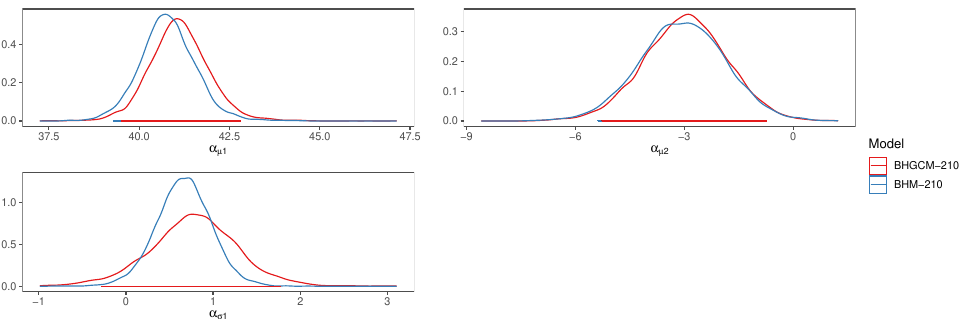
Figure 3. Estimated posterior distribution density functions of the regression coefficients α k 1 ( left ) and α k 2 ( right ) for the location ( top row) and scale ( bottom row) parameters for the models BHM-210 (blue line) and BHGCM-210 (red line). The red horizontal lines show the 0.025 to 0.975